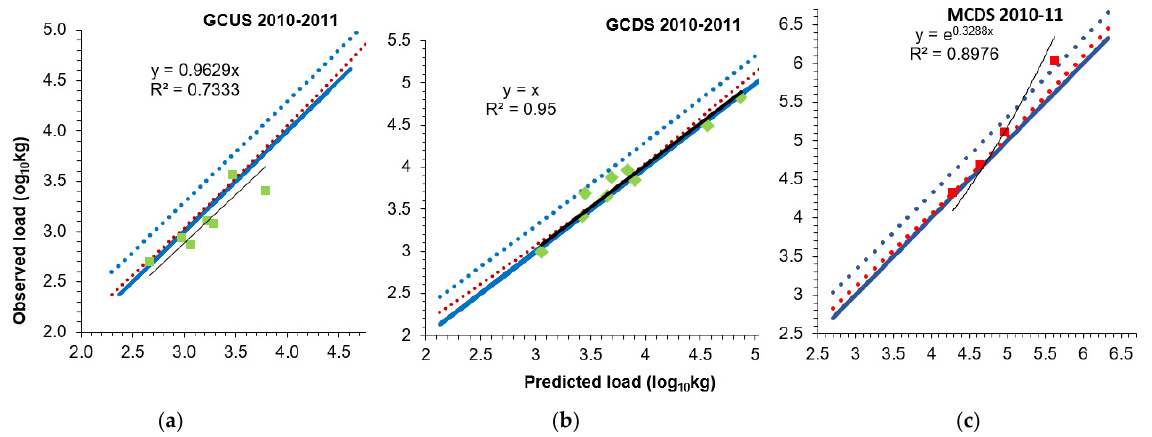
Figure 10. Relationship between OTL and PTL at GCUS ( a ), GCDS ( b ), and MCDS ( c ) (2010–2011). See Figure 7 for the explanation of the lines and colors of the points.